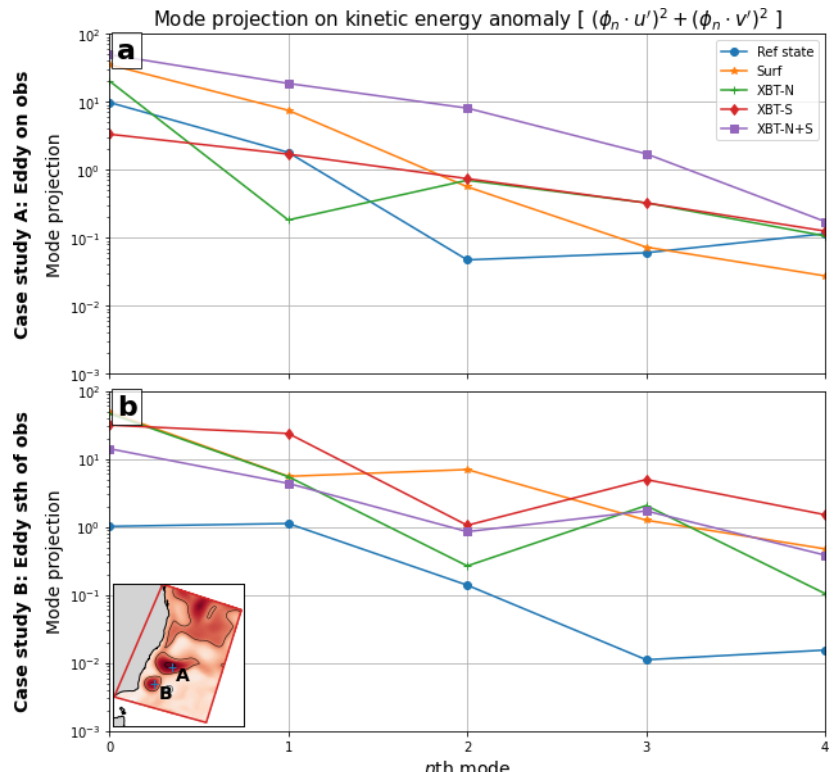
Figure 10. The barotropic and baroclinic modes are projected onto the kinetic energy through the squared addition of the mode projections on the zonal and meridional velocity anomalies (see Sect. 2.3.4). In (a) , the value of the n th mode projections for case study A are shown, and in (b) , the n th mode projections for case study B are shown. The locations of case studies A and B are shown in the inset in (b)